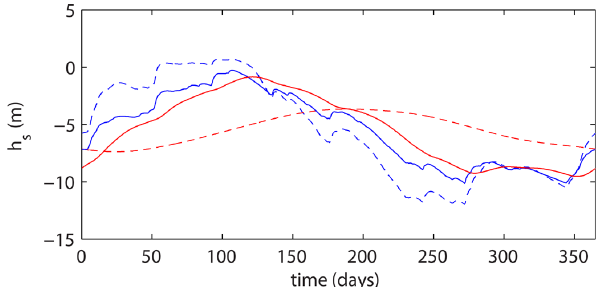
Fig. 4. The influence of the hydraulic conductivity of saturated silt on the head at the bottom of the varved clays during 1958 for k s = 0 . 001mday − 1 (dashed lines) and k s = 0 . 01mday − 1 (solid lines) at the fissure ( x = 0, blue lines) and halfway between two fissures ( x = L , red lines). Head variations are shown with respect to the bottom of the colluvium/top of the varved clays.